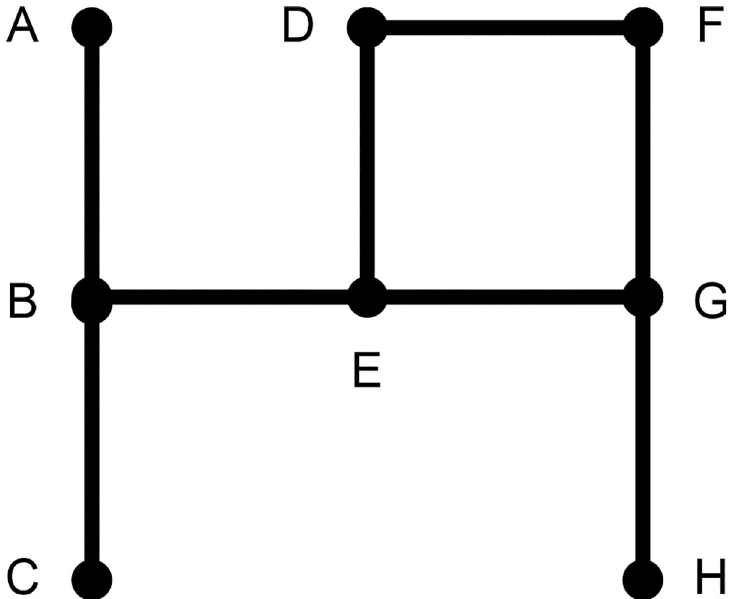
Fig 1. Hypothetical network illustrating the differences between walks, trails, and